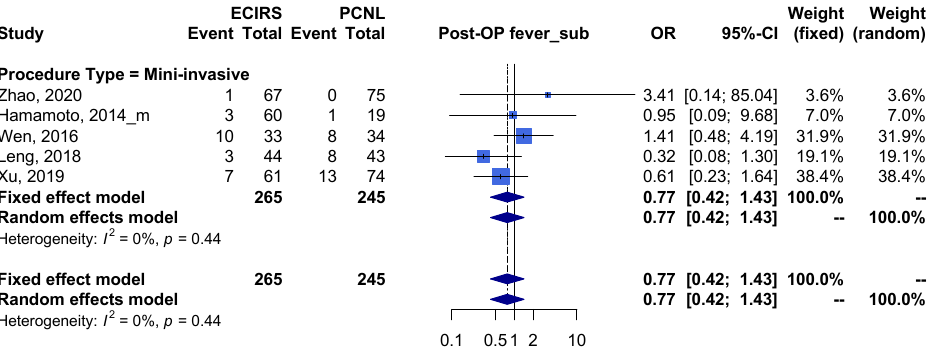
Figure A5. Subgroup analysis of outcome regarding post-operative fever. (Mini: [17–19][22,23])